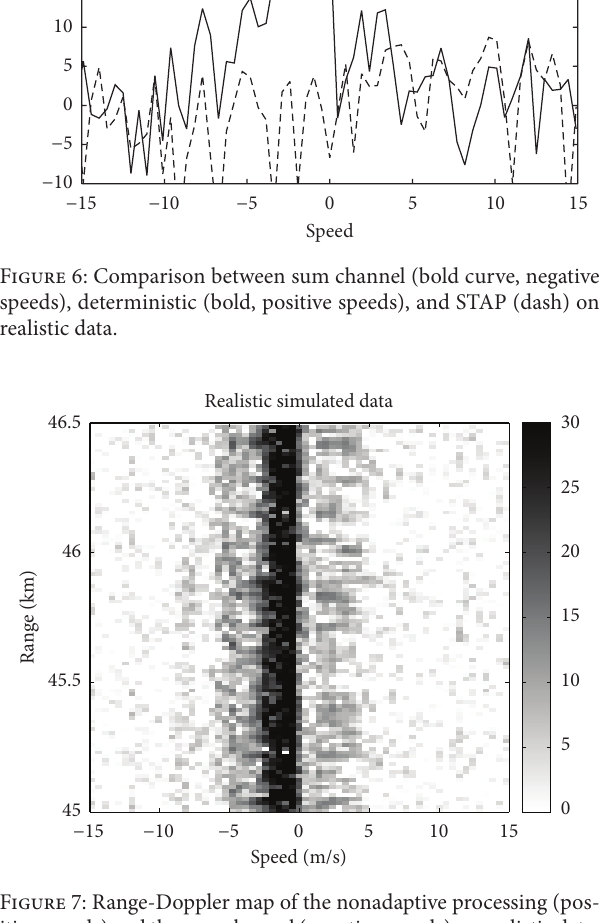
Figure 7: Range-Doppler map of the nonadaptive processing (pos- itive speeds) and the sum channel (negative speeds) on realistic